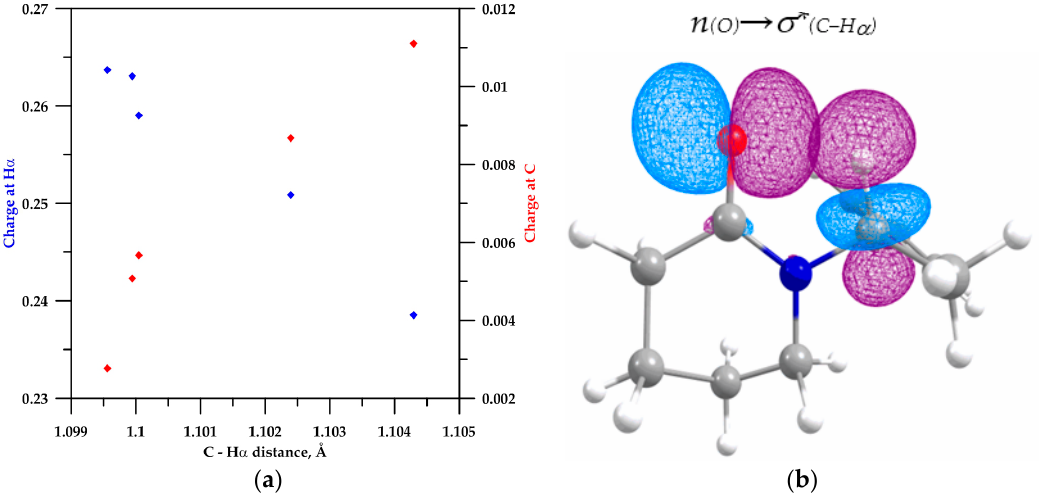
Figure 4. ( a ) Correlation of population of charges for H and C in the C − H α bond with the C − H α distance (charge of H in blue and for C in red); ( b ) NBO plots illustrate the overlap of the n (o) orbital and the σ * (C − H α ) orbital in the conformer 4a .